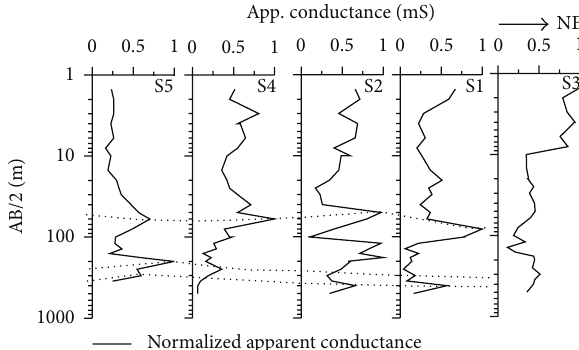
Figure 5: Normalized apparent conductance ( 𝐶 𝐴 ) for five sound- ings.